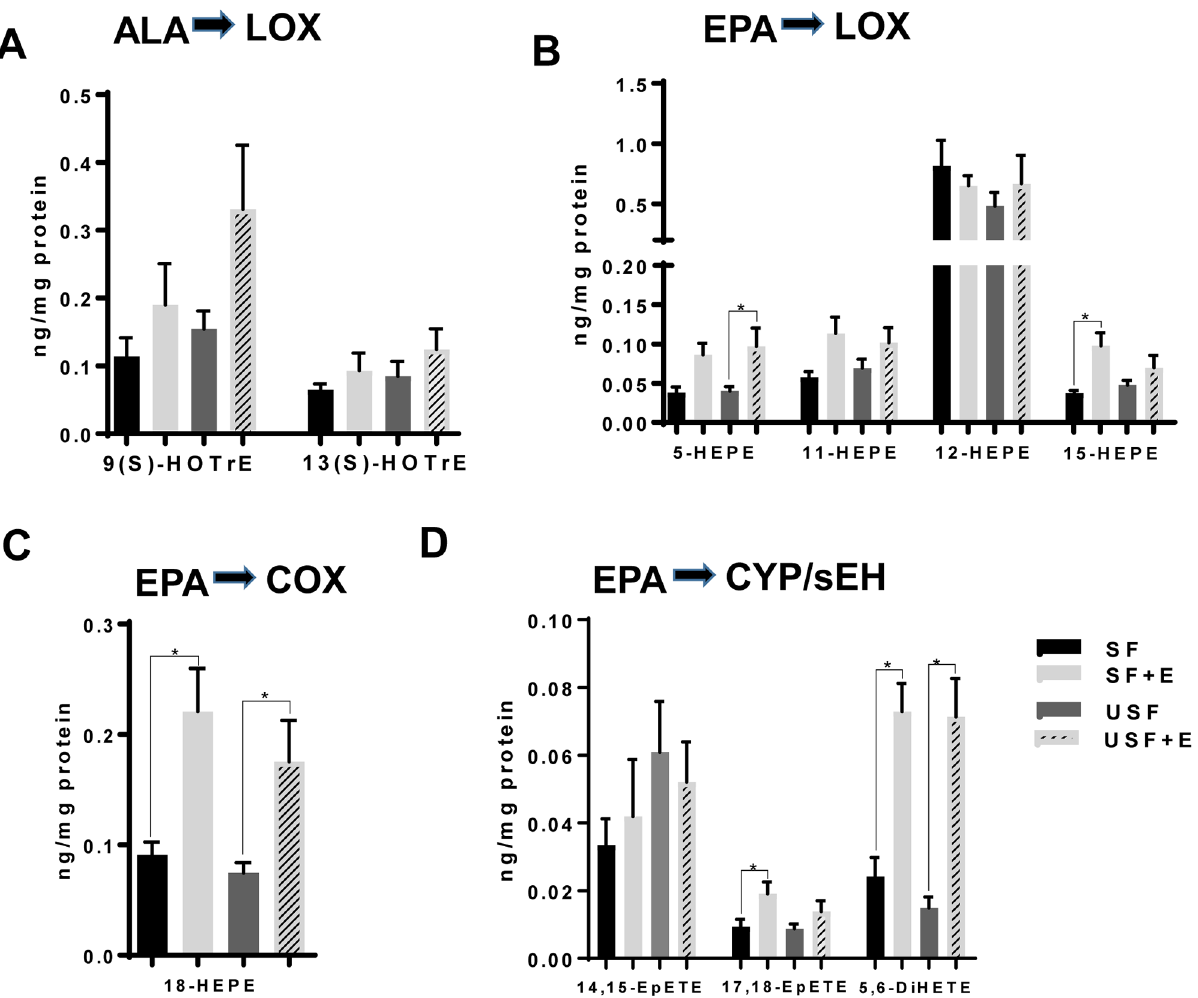
Fig 7. Changes in hepatic oxylipins derived from ω -3 PUFAs, linolenic and EPA. A: Levels of ALA hydroxy-metabolites of LOX pathway. B. Changes in the profile of LOX-dependent hydroxy-metabolites of EPA. C: 18-HEPE levels, COX pathway. D: Changes in epoxy- and dihydroxy-metabolites of EPA derived via CYP/sEH pathway. Data are presented as the mean ± SEM, Two way ANOVA, (cid:3) P < 0.05, n = 6 animals per group. ALA, alpha linolenic acid; CYP, cytochrome-P450 epoxygenase; E, ethanol; EPA, eicosapentaenoic acid; LOX, lipoxygenase; SF, saturated fat; sEH, soluble epoxide hydrolase; USF, unsaturated fat. See oxylipin abbreviations in S6 Table.